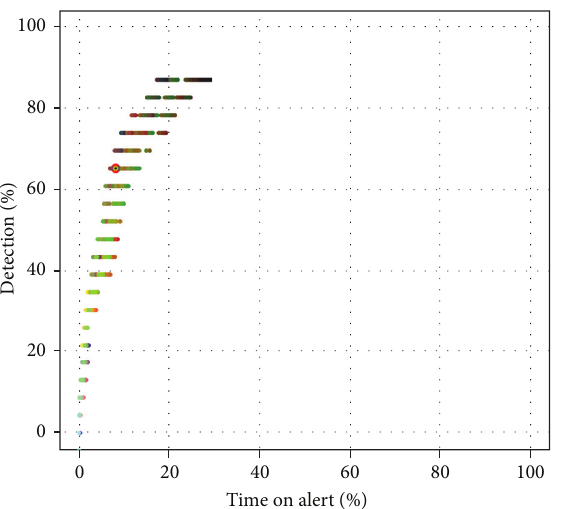
Figure 6: Early alerting ROC curve for windshear generated by a short-range LIDAR during the 2013 field experiment. The colored dots represent the performance of the new early alerting algorithm using a combination of thresholds for spatial and temporal changes in radial wind velocities. The red circle represents the performance of